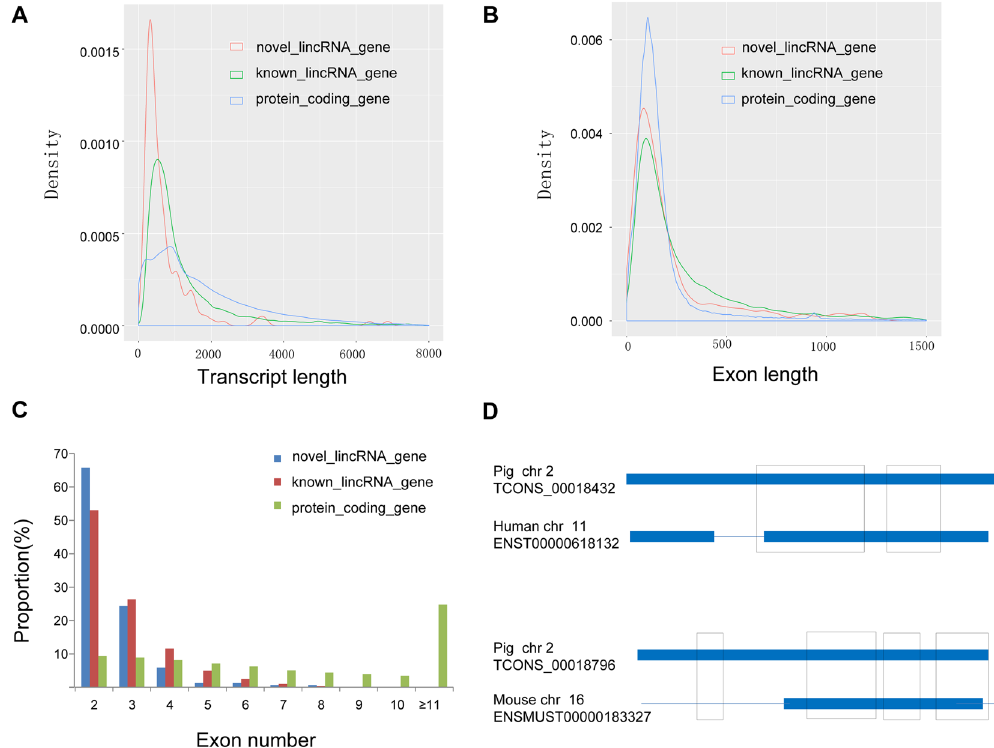
Figure 3. Comparisons of transcript length, exon length and exon number between novel lincRNA genes, known lincRNA genes and protein-coding genes. ( A ) Comparisons of transcript length. Novel lincRNA genes show shorter average transcripts length (776 bp) than that of the known lincRNA genes (1,361 bp) and the protein-coding genes (1,828 bp); ( B ) Comparisons of exon length. Novel lincRNA genes show shorter mean exon length (307 bp) than that of the known lincRNA genes (450 bp) but longer than that of the protein-coding genes (233 bp); ( C ) Comparisons of exon number. Novel lincRNA genes trend to have less exons than that of the known lincRNA genes (2.5 vs 2.8) and protein-coding genes (2.5 vs 7.8); ( D ) Representative images of conserved regions between pig lincRNAs with human and mouse lincRNAs. Thick lines indicate an exon and thin lines indicates an intron of the lincRNAs. Boxes indicate the conserved region between two